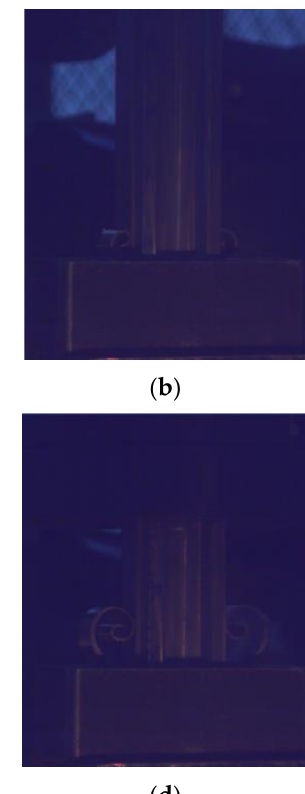
Figure 3. Simulation Model.